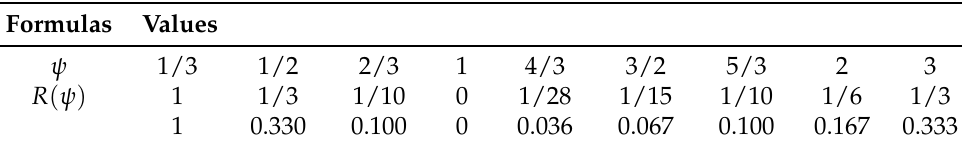
Table 2. Several values of the ratio ψ of forcing decay to free damping and the corresponding total energy of oscillation as a fraction R of the energy of the free oscillation, showing large reductions, which means strong vibration